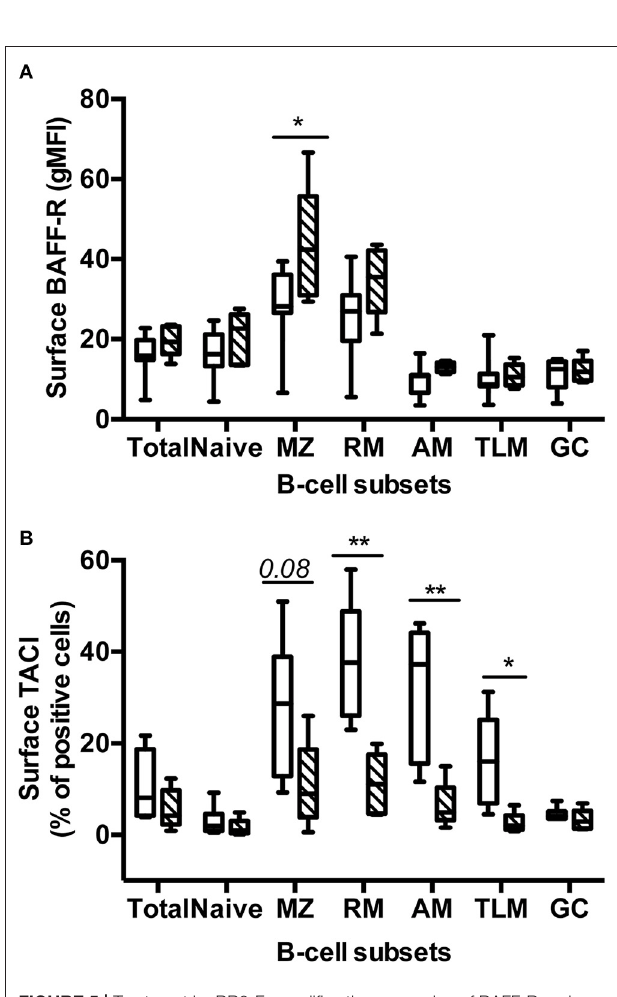
FIGURE 5 | Treatment by BR3-Fc modifies the expression of BAFF-R and TACI by spleen B-cells. Surface expression of BAFF-R ( A , gMFI) and TACI ( B , % of positive cells) were analyzed in every B-cell subset from 7 Placebos ( white bar) and 5 Treated macaques ( hatched bar) . Results are presented in box-and-whiskers (5–95 percentile) plots with horizontal bars indicating median values. Statistical comparison between groups was performed using Mann Whitney non-parametric test. Significant statistical values are indicated: * p < 0.05 and ** p < 0.01.